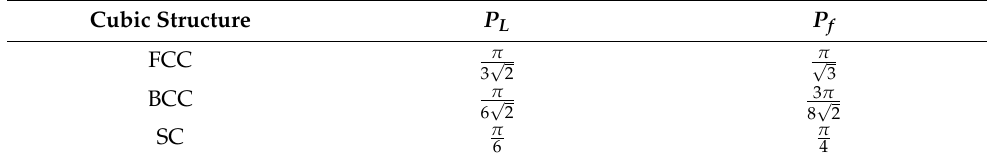
Table 1. The values of the volume and the surface packing factors for different cubic structures [27]. Cubic